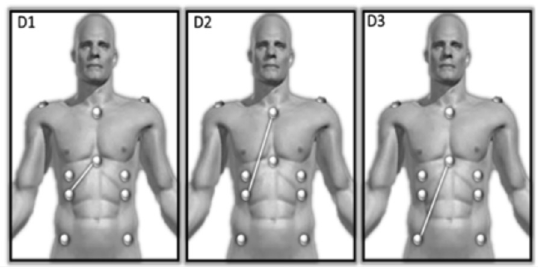
Figure 2 - D1. Xiphoid process/last false rib; D2. Manubrion/ last false rib; D3. Xiphoid process/Antero-superior iliac spine.